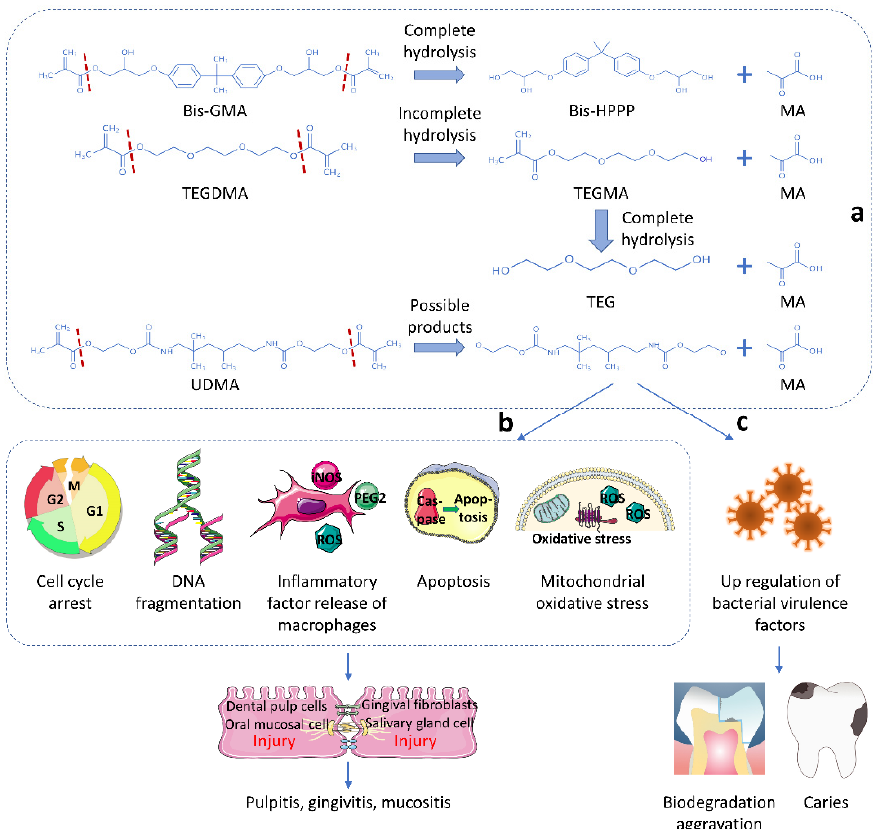
Figure 2. Biodegradation products of macromolecular monomers and the impact of monomers on oral health. ( a ) The ester bond of a macromolecular monomer is broken to form small monomers. ( b ) Monomers affect the physiological activities of cells, leading to local oral inflammation. ( c ) Monomers exacerbate the expression of bacterial virulence factors, and aggravate secondary caries and biodegradation.